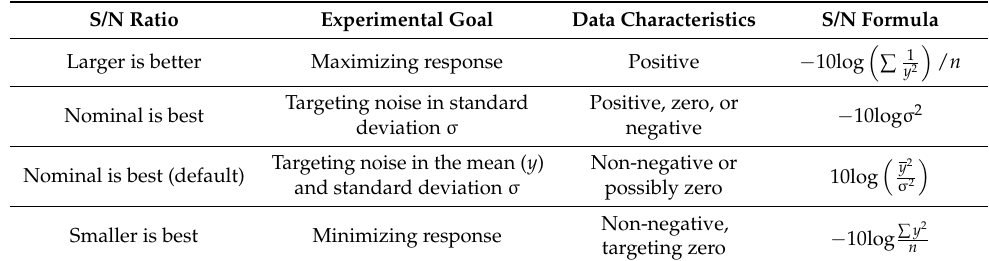
Table 1. S/N ratio and experimental